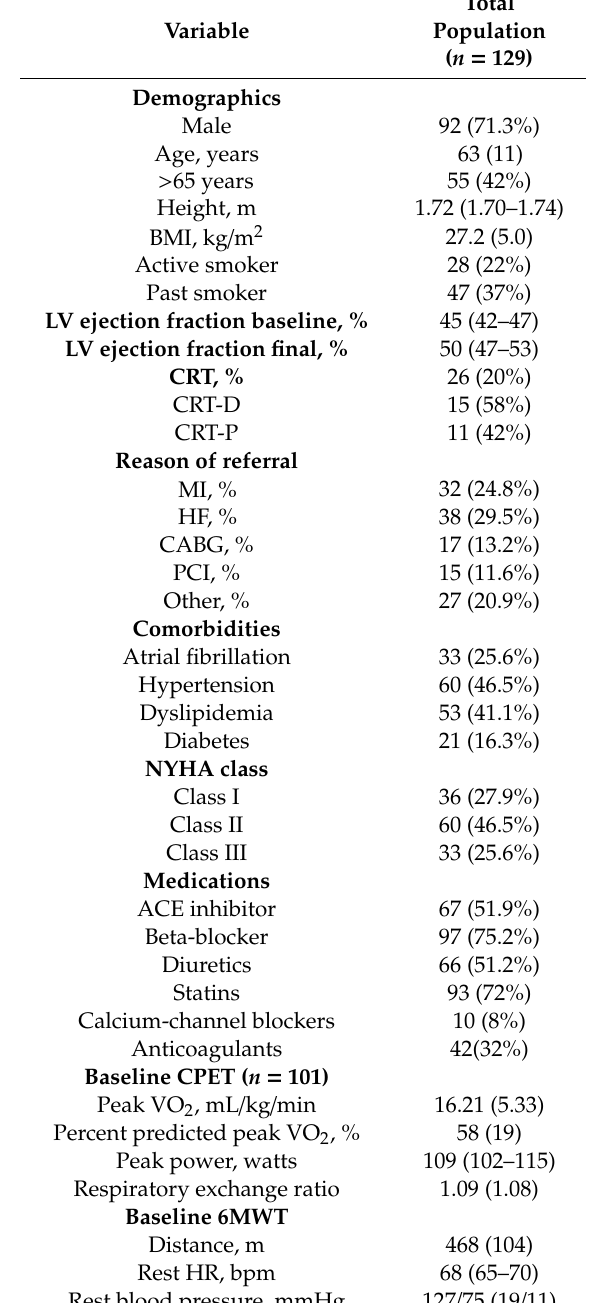
Table 1. Baseline